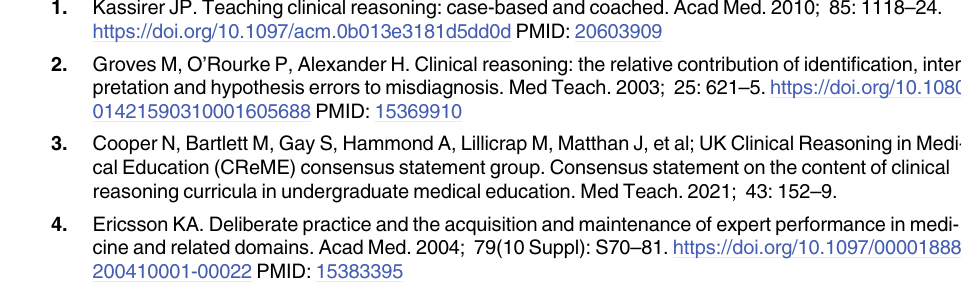
S2 Table. The questionnaire of the Fifth-year medical students’ perceived competence in PBL, satisfaction with sessions, and self-evaluation of competency in clinical reasoning about hybrid- and pure-PBL, Chiba University Hospital (N =